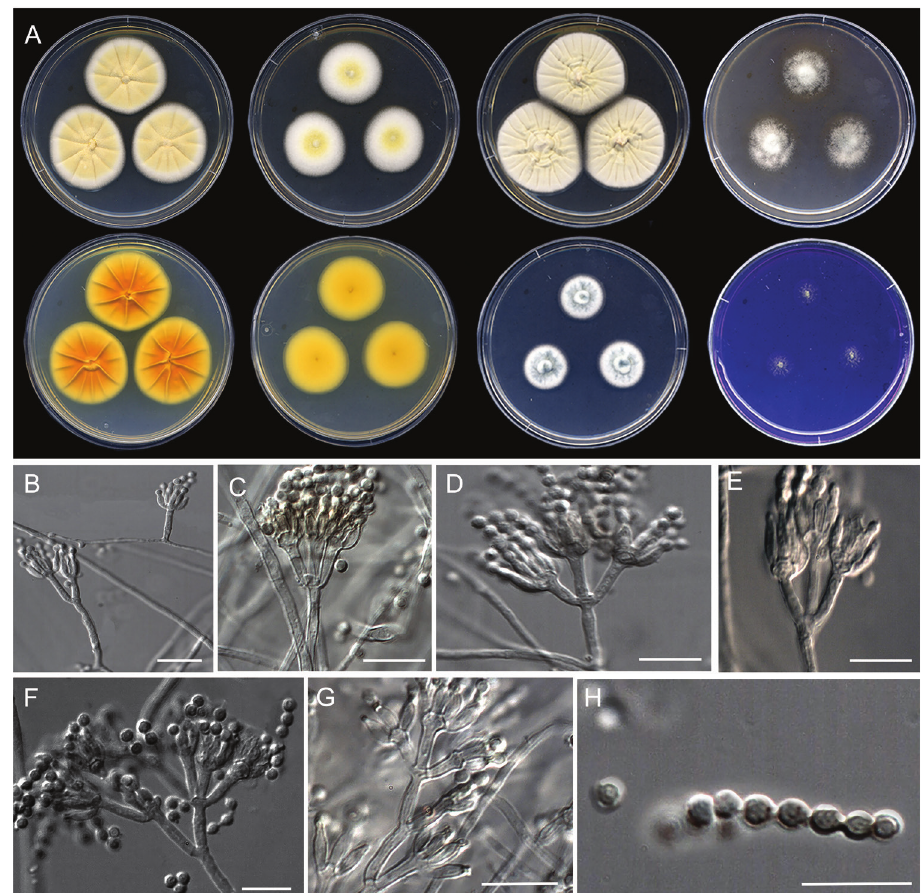
Figure 12. Morphological characters of Penicillium irregulare sp. nov. (ex-type FMR 17859). A colonies from left to right (top row) CYA, MEA, YES, and OA; (bottom row) CYA reverse, MEA reverse, DG18, and CREA B–G conidiophores on MEA H conidia. Scale Bars: 10 μm ( B–H